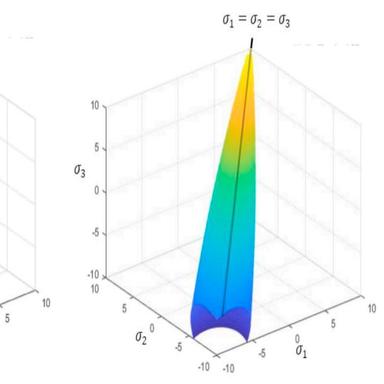
Overall flow of the analysis algorithm in UMAT for NP Cf/SiCm.